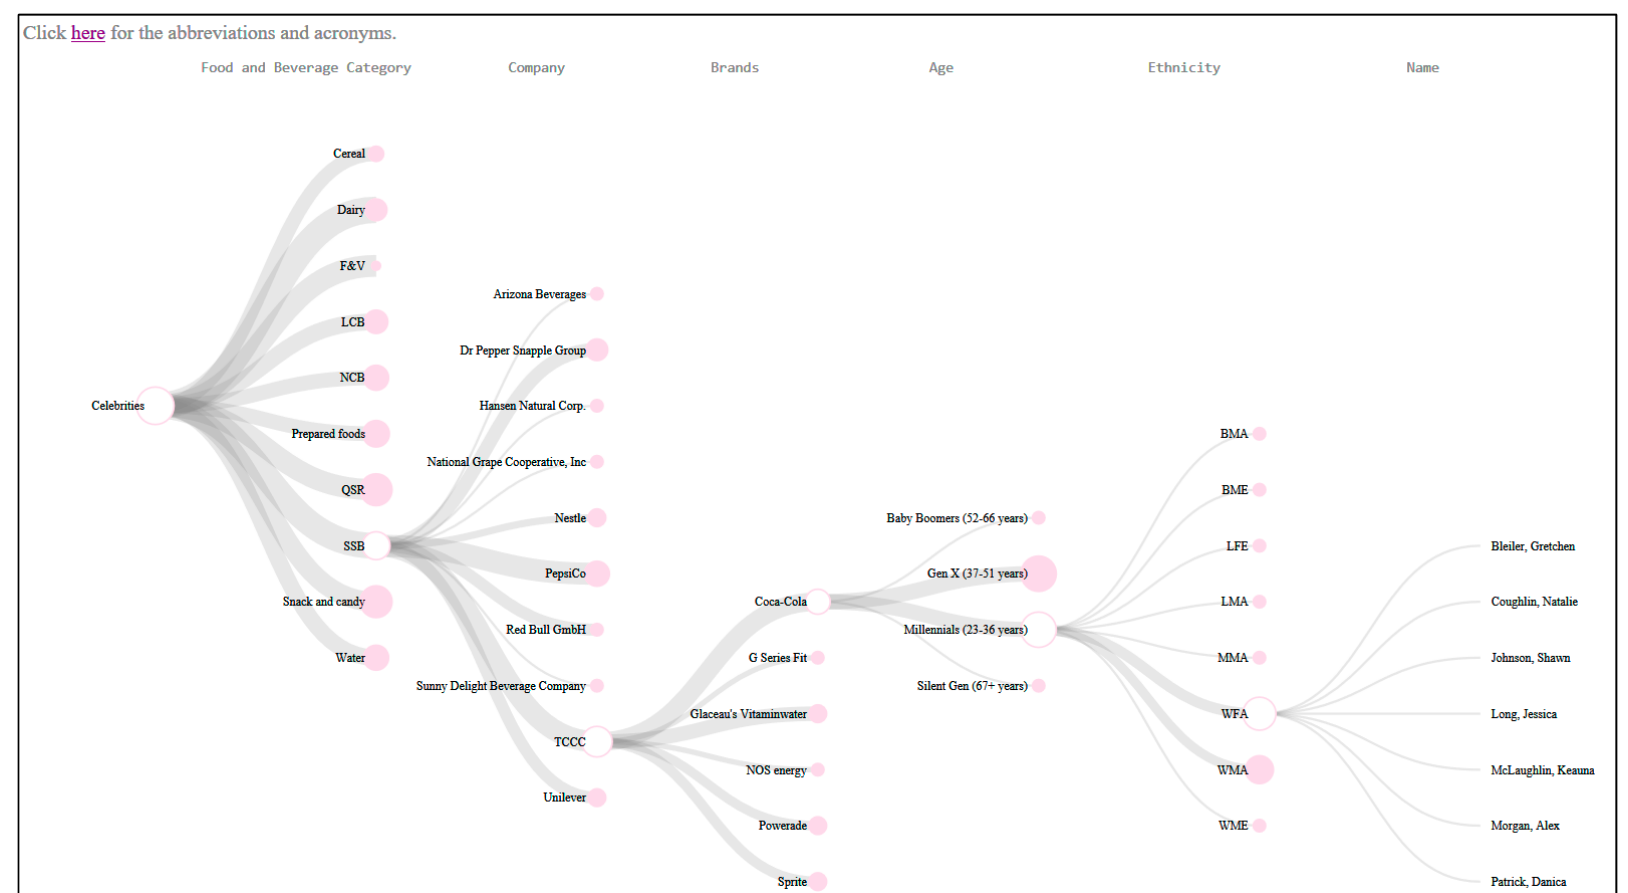
Figure 3. Screenshot of an interactive dendrogram showing the celebrity endorsement relationships by the food and beverage category ( n = 10), companies ( n = 59) and celebrities ( n = 542). We created two dendrograms that emphasized the endorsement relationships from different perspectives: dendrogram one emphasizes the food and beverage category endorsements and dendrogram two emphasizes the company endorsements. The two interactive dendrograms can be viewed online [47] in any web browser by disabling the browser protection to enable the loading of files required for the D3-based visualization.